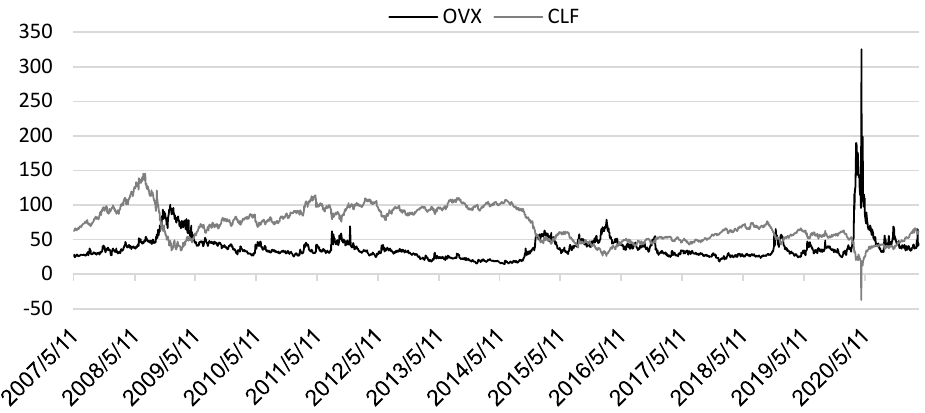
Figure 1. Crude Oil Future Contract—CLF (USD per barrel) and CBOE Crude Oil Volatility Index— OVX in 11 May 2007–30 March 2021.